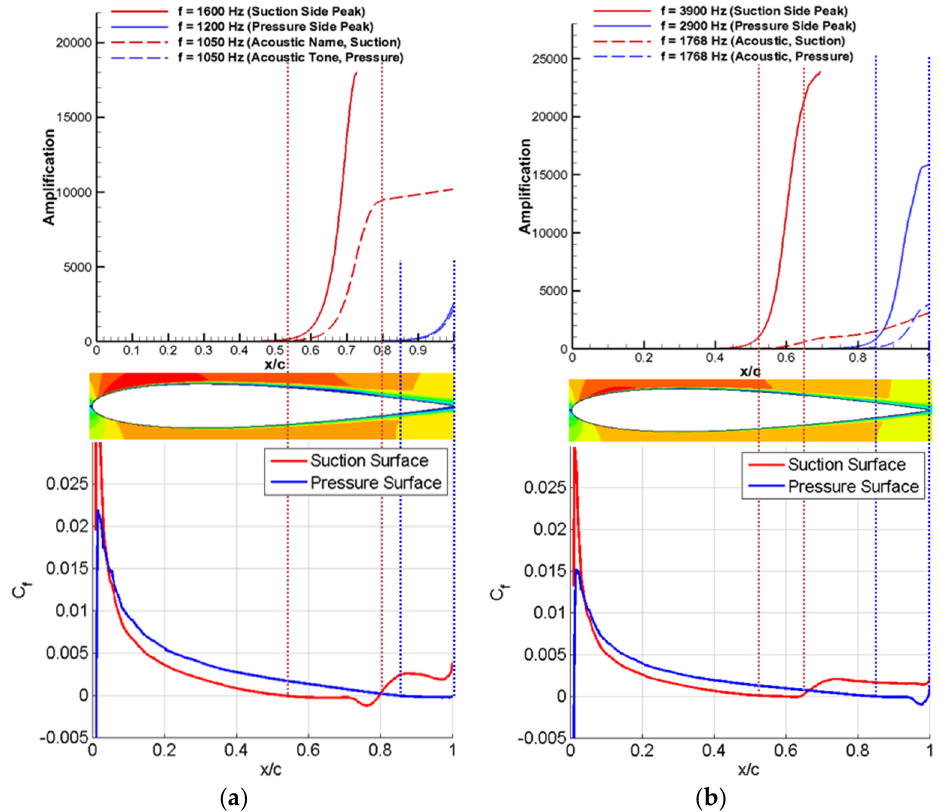
Figure 19. Linear stability analysis (LSA) results (correlated with numerical predictions of laminar separation bubble (LSB) zones) showing instability chordwise amplification on suction and pressure sides for Re = 144,000 ( a ) and Re = 288,000 ( b ). [18].